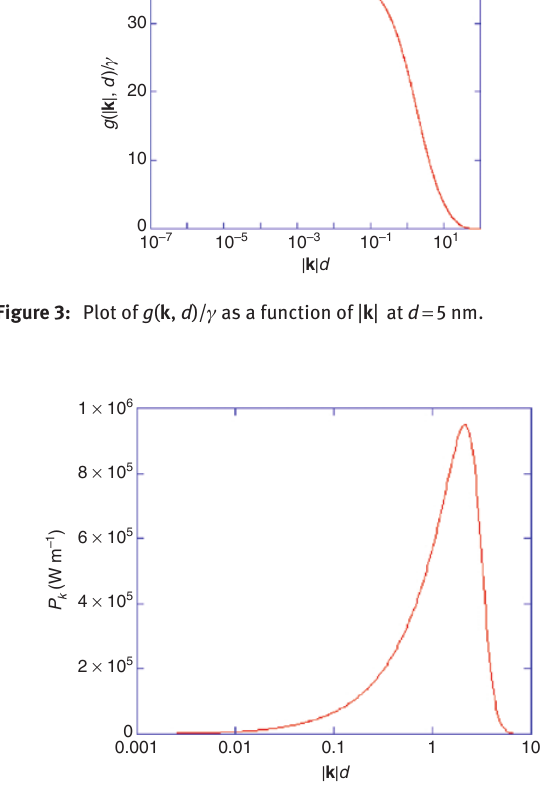
Figure 4: Plot of the integrand in Eq. (15) when t → ∞ as a function of | k | d (W m −2 ) at d = 5 nm.